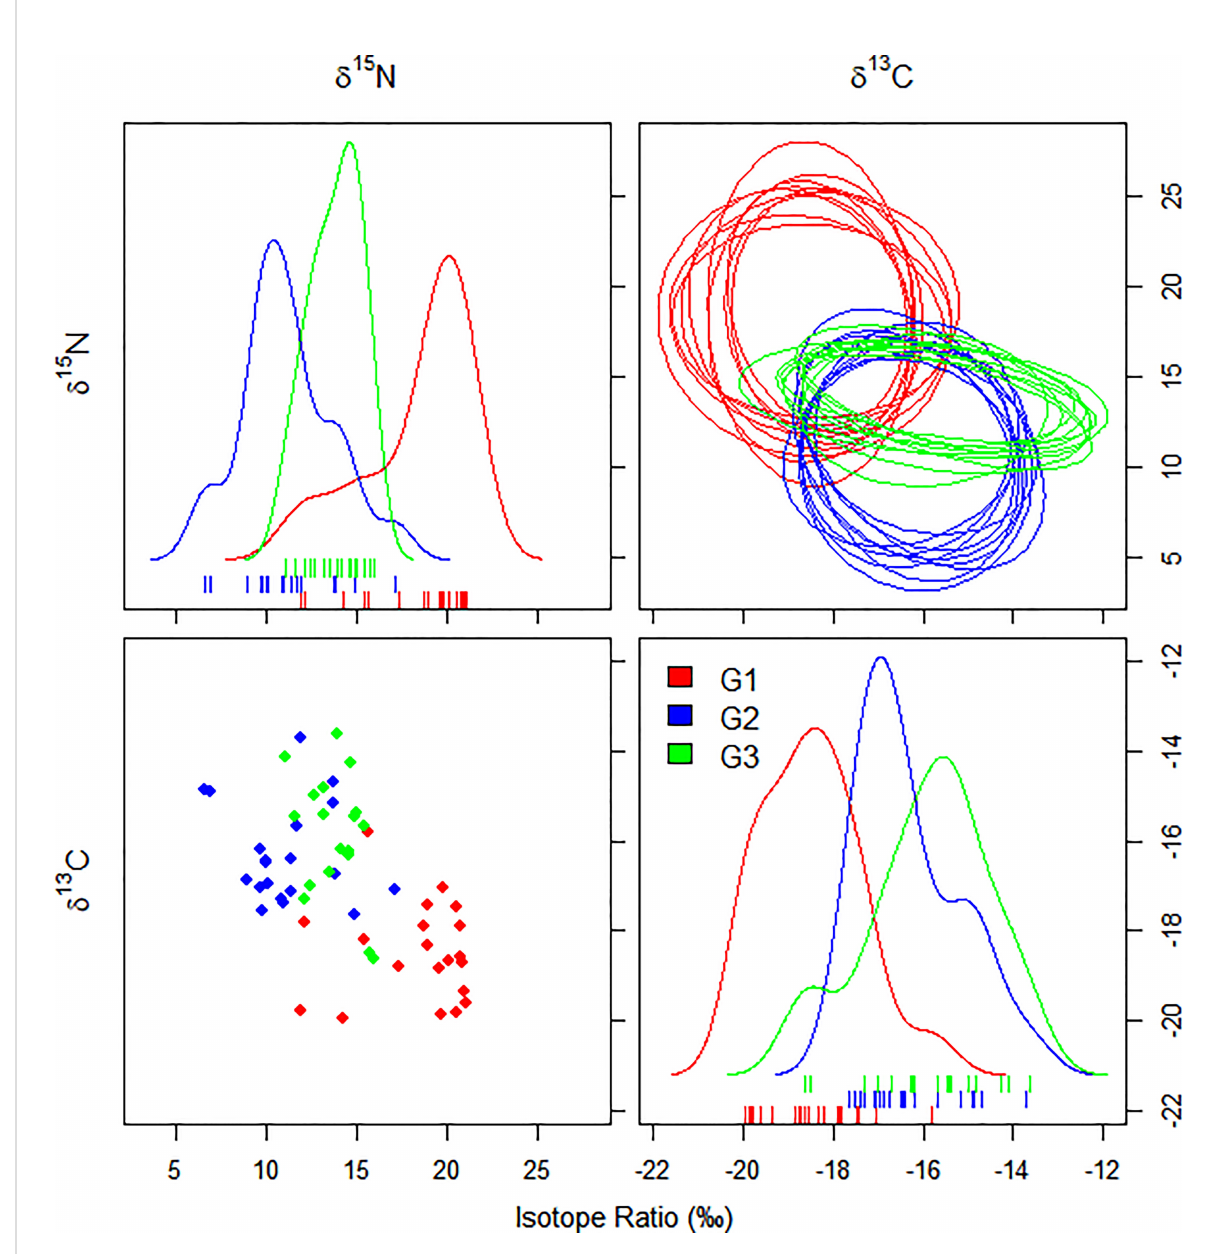
FIGURE 7 Ten random elliptical projections of trophic niche region (NR) for each tuna species and pair of isotopes (elliptical plots). One-dimensional density plots (lines) and two-dimensional scatterplots are also displayed. G1, big eye tuna, Thunnus obesus ; G2, yellow fi n tuna, T. albacares ; G3, albacore tuna, T. alalunga